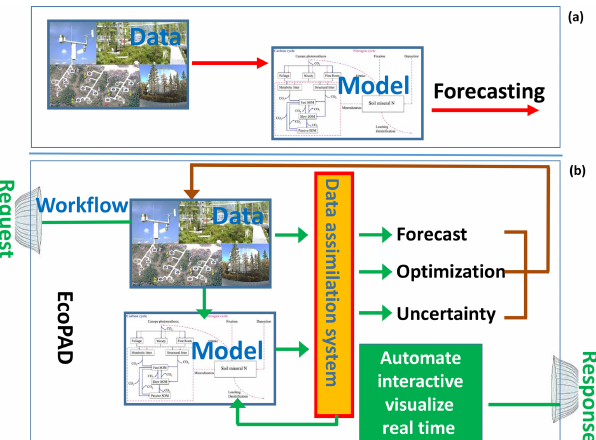
Figure 1. Schema of approaches to forecast future ecological re- sponses from common practice (a) and the Ecological Platform for Assimilation of Data (EcoPAD, v1.0) (b) . The common prac- tice makes use of observations to develop or calibrate models to make predictions, while the EcoPAD (v1.0) approach advances the common practice through its fully interactive platform. EcoPAD (v1.0) consists of four major components: experiment and data, model, data assimilation, and the scientific workflow (green ar- rows or lines). Data and model are iteratively integrated through its data assimilation systems to improve forecasting. Its near-real- time forecasting results are shared among research groups through its web interface to guide new data collections. The scientific work- flow enables web-based data transfer from sensors, model simula- tion, data assimilation, forecasting, result analysis, visualization, and reporting, encouraging broad user–model interactions, espe- cially for experimenters and the general public with a limited back- ground in modeling. Images from the SPRUCE field experiments (https://mnspruce.ornl.gov/, last access: January 2019) are used to represent the data collection and the flowchart of the TECO model is used to delegate ecological